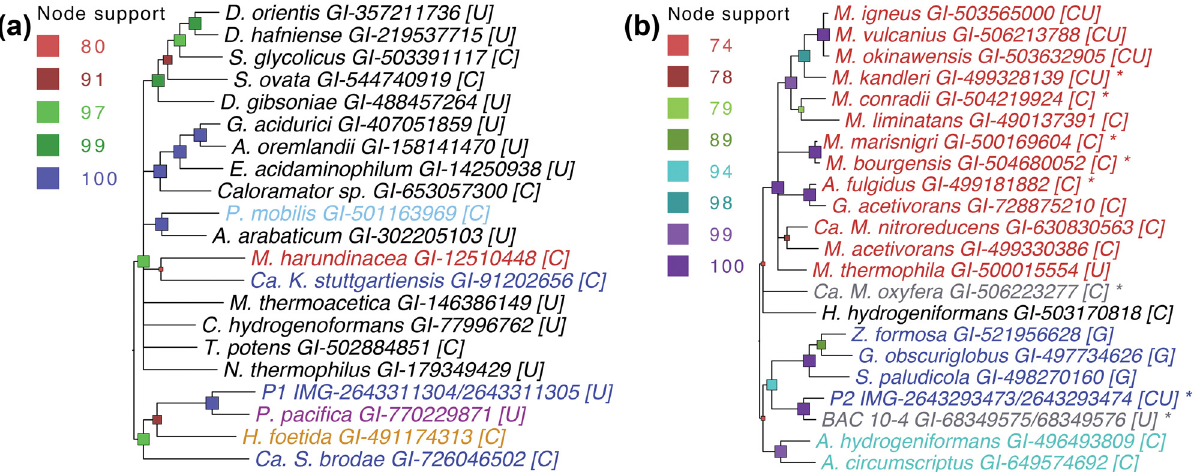
Fig 7. Horizontal gene transfer of selenoprotein genes reflects adaptation to stress conditions. (a) Phylogeny of formate dehydrogenase α subunit ( fdhA ). Closest non-redundant hits (BLASTp against NCBI nr) to the P1 selenoprotein sequence are shown. (b) Phylogeny of formylmethanofuran dehydrogenase β subunit ( fmdB ). Closest non-redundant hits to the P2 selenoprotein sequence are shown. Asterisk indicates a similar formylmethanofuran dehydrogenase operon structure as in P2 ( fmdD - fmdB - fmdA - fmdC ). In both (a) and (b) , genes are color-coded by organism as follows: Planctomycetes [blue], Proteobacteria [purple], Acidobacteria [orange], Thermotogae [light blue], Firmicutes [black], and Archaea [red], Synergistetes [cyan], unclassified [gray]. Sequences containing selenocysteine are marked with [U] and cysteine-containing sequences are marked with [C]. Node support is from 1000 bootstrap